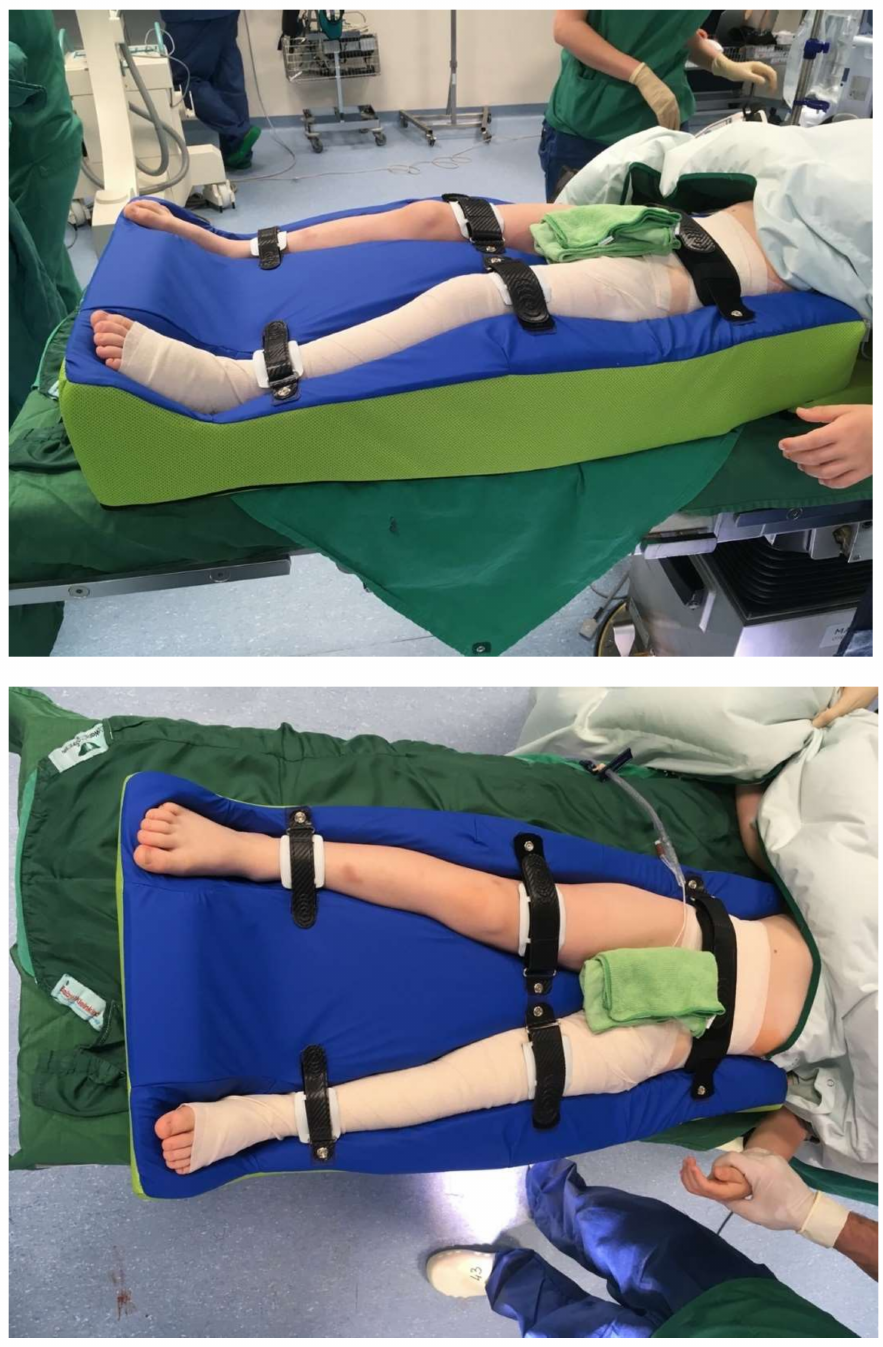
Figure 3. Postoperative foam